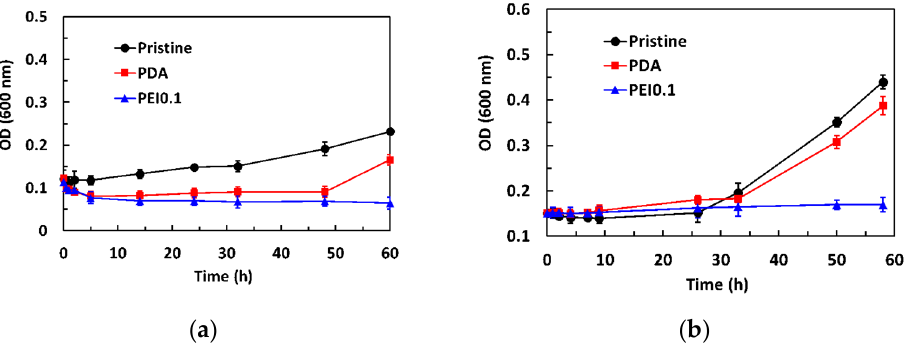
Figure 6. Antibacterial activity of dynamic contact test for different filter papers. ( a ) S. aureus ( b ) E. coli.